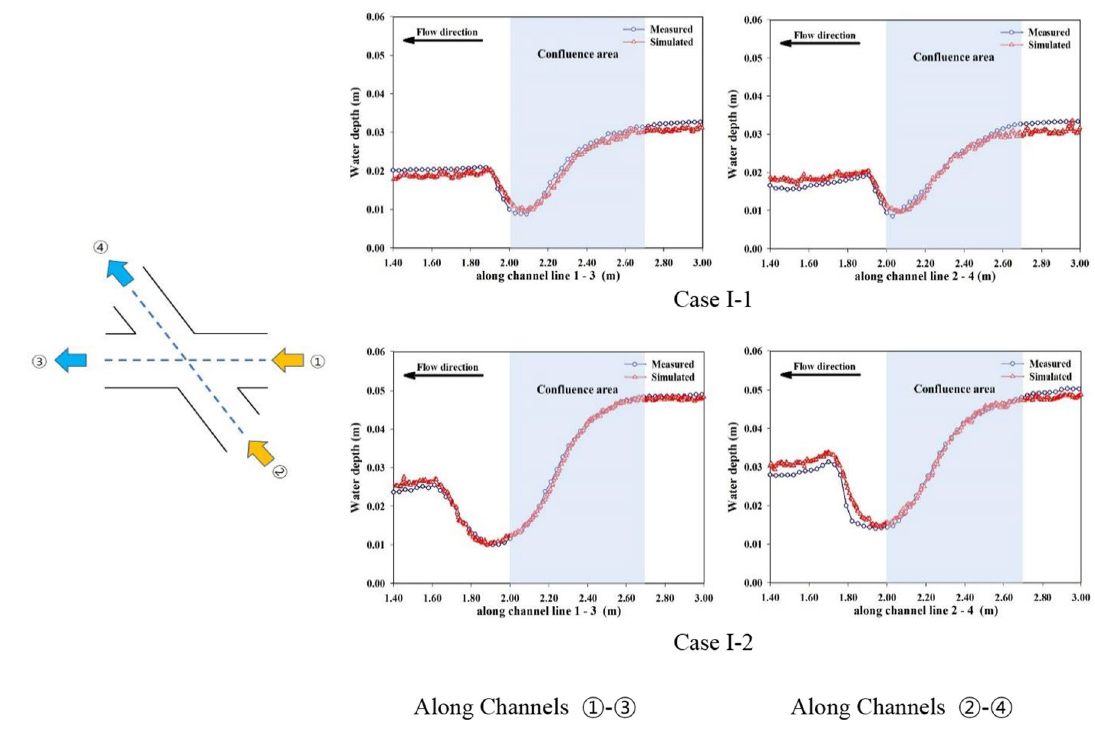
Fig. 9 Water-surface profiles along channels for Case I